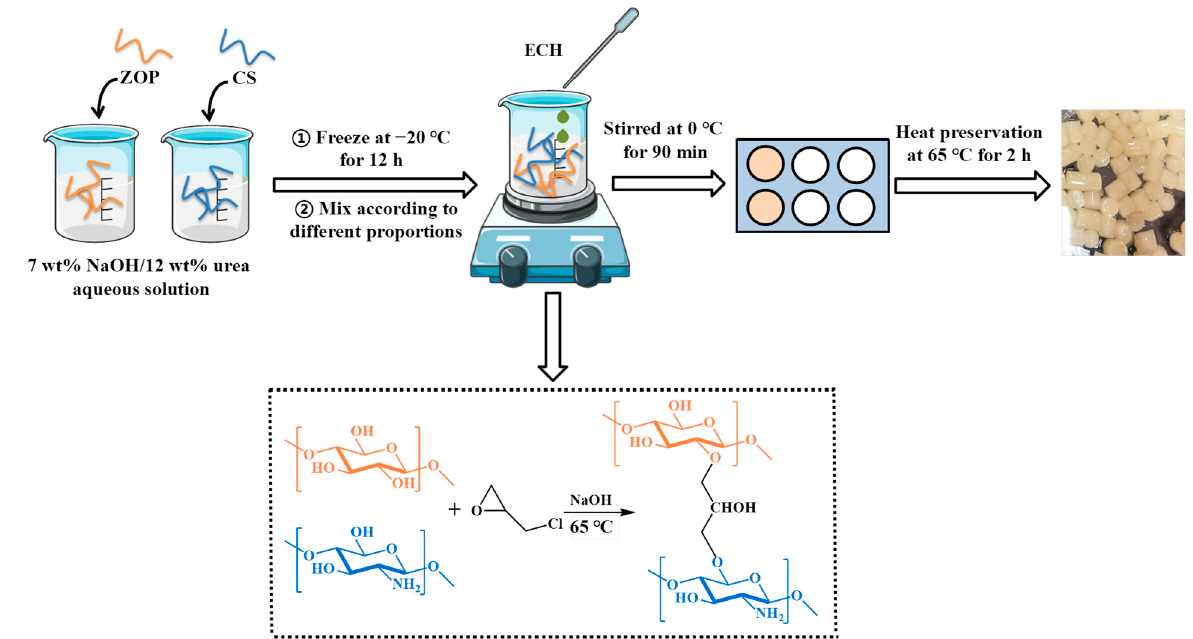
Figure 1. Hydrogel preparation process.